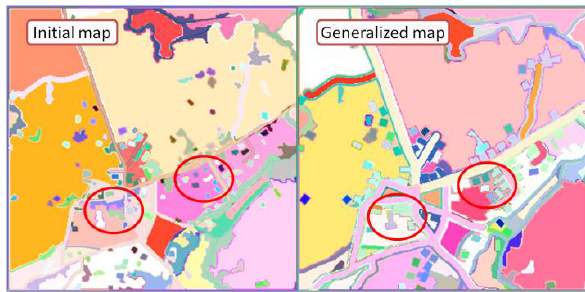
Figure 11. Generalization increases building size and density